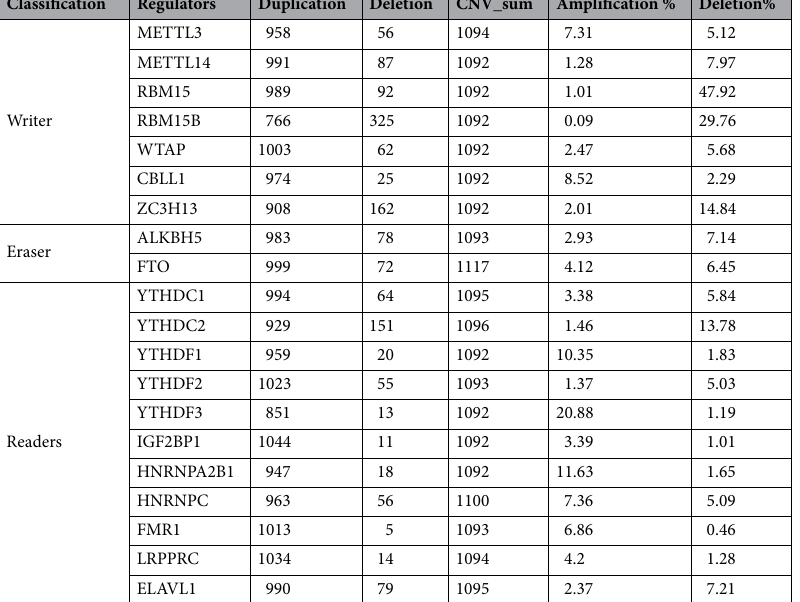
Table 1. m6A modification proportions among 20